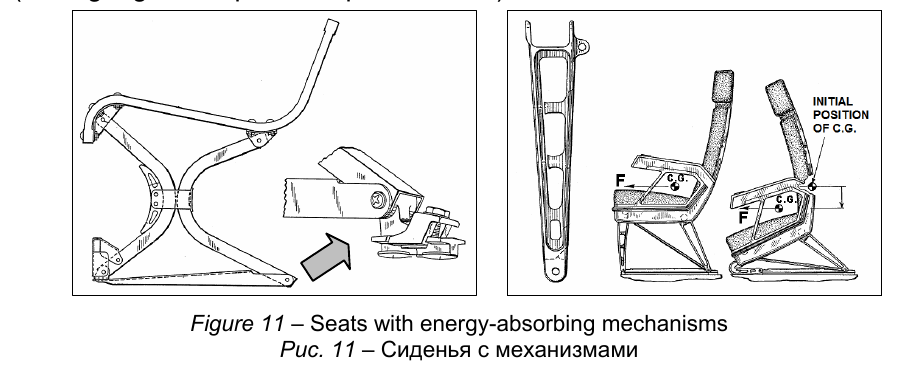
Figure 11 – Seats with energy-absorbing mechanisms Рис . 11 – Сиденья с